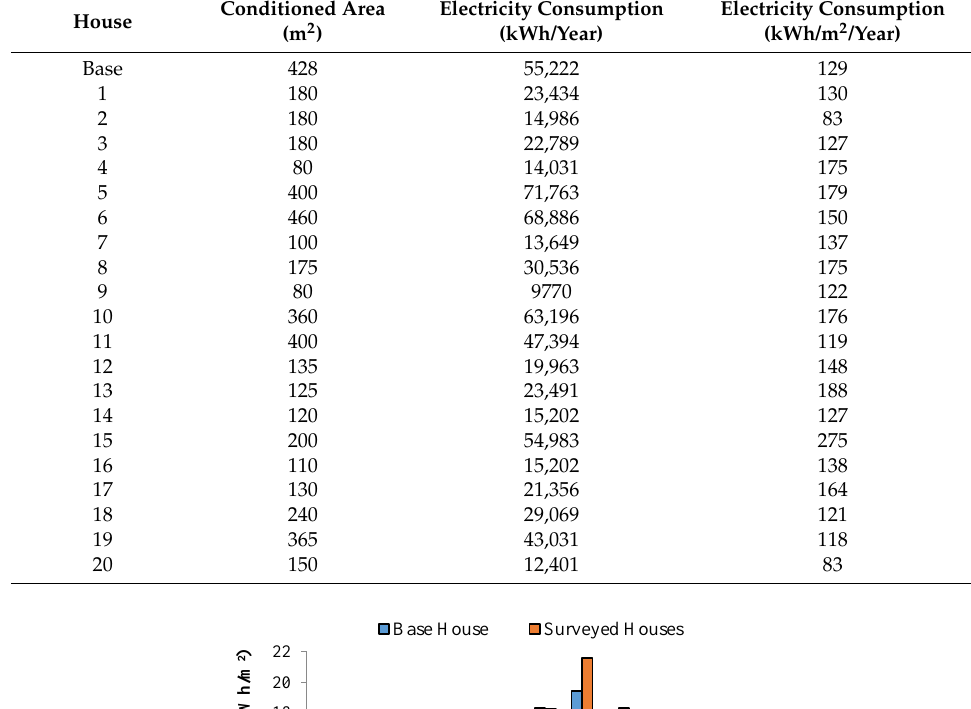
Table 3. Conditioned area and electricity consumption for the base and surveyed houses.